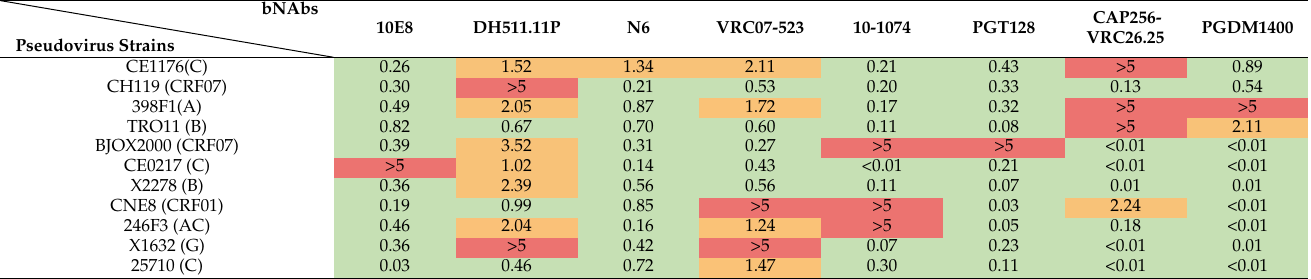
Table 1. Mean IC 50 values (n = 2) for single antibodies.